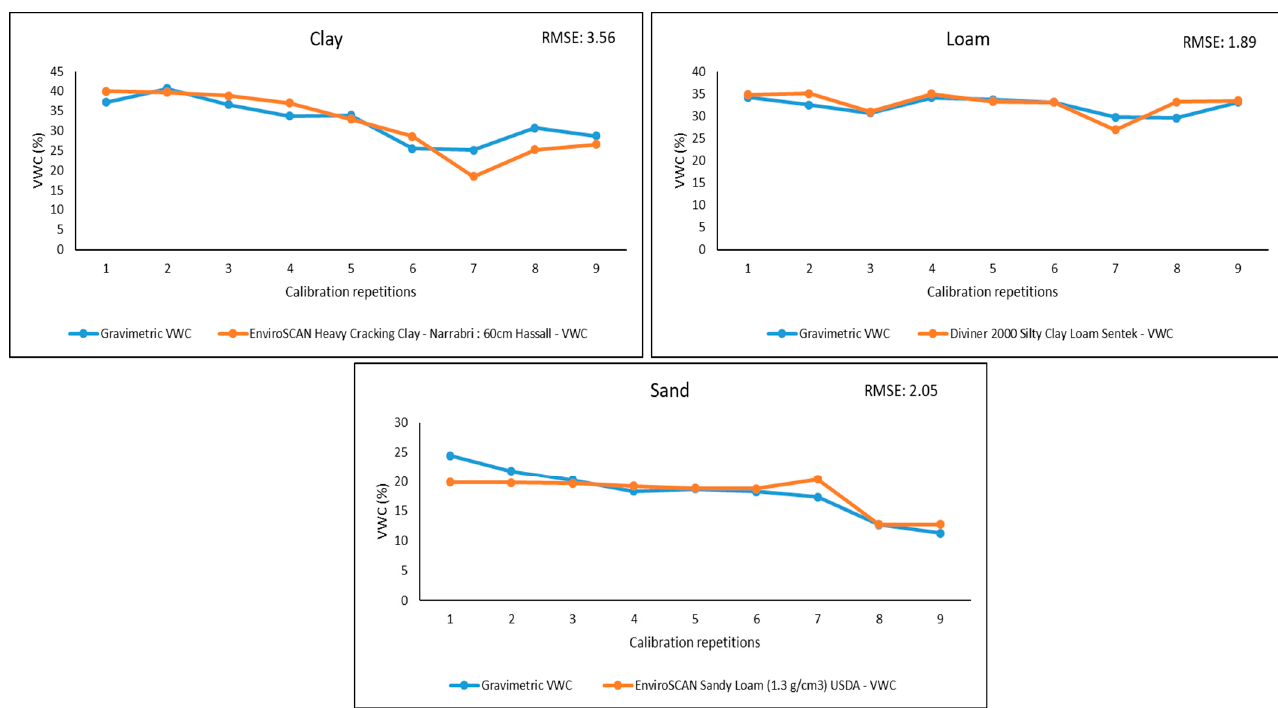
Figure 5. Gravimetric VWC (blue line) compared to calculated VWC using the best fitting equations (orange lines) of EnviroScan sensor.